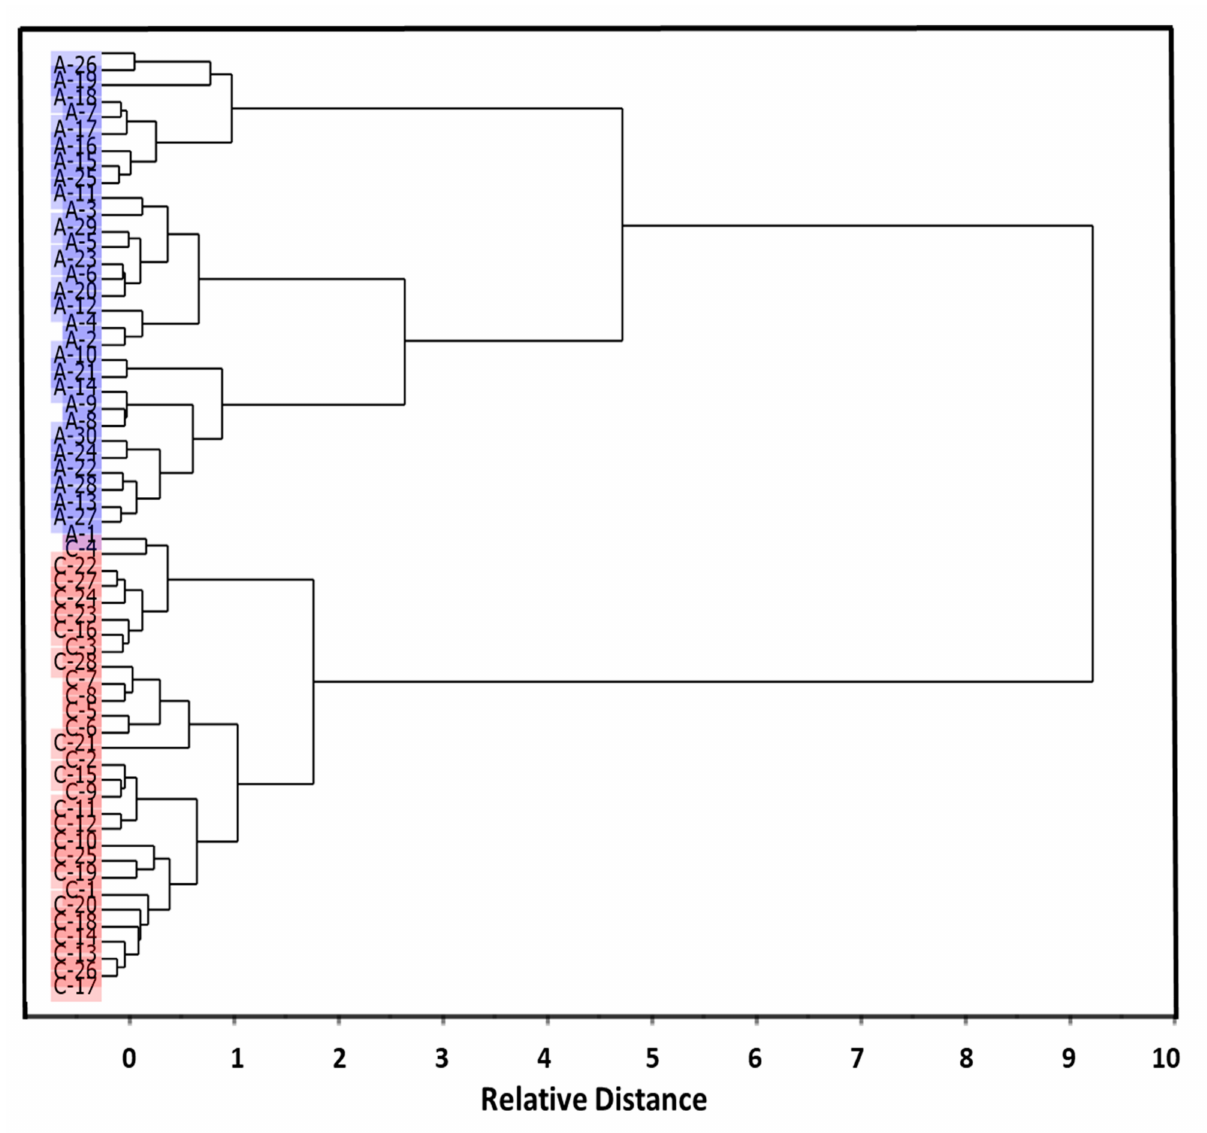
Figure 3. Hierarchical cluster analysis of ADHD (A; highlighted in blue) and control (C; highlighted in red) groups’ blood serum IR spectra, according to the Ward’s method, using squared Euclidean